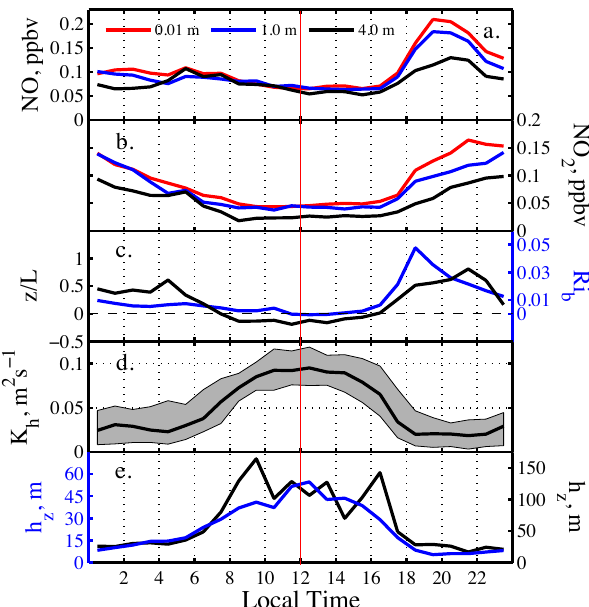
Fig. 5. The asymmetry in diurnal cycles of mixing ratios and physi- cal boundary layer variables with respect to local noon (vertical red line): (a) NO mixing ratios, (b) NO 2 mixing ratios, (c) atmospheric stability as expressed by the Monin-Obukhov length ratio z/L , with sonic anemometer height z , and bulk Richardson number Ri b , (d) turbulent diffusion coefficient of heat K h at 1m and (d) boundary layer height h z estimated after Pollard et al. (1973) (blue line) and Zilitinkevitch et al. (2002) (black line); note different y-axis scales. Lines represent median values and shaded areas the range between the 0.25 and 0.75 percentiles of 1-hourly bins during 22 December 2009–28 January